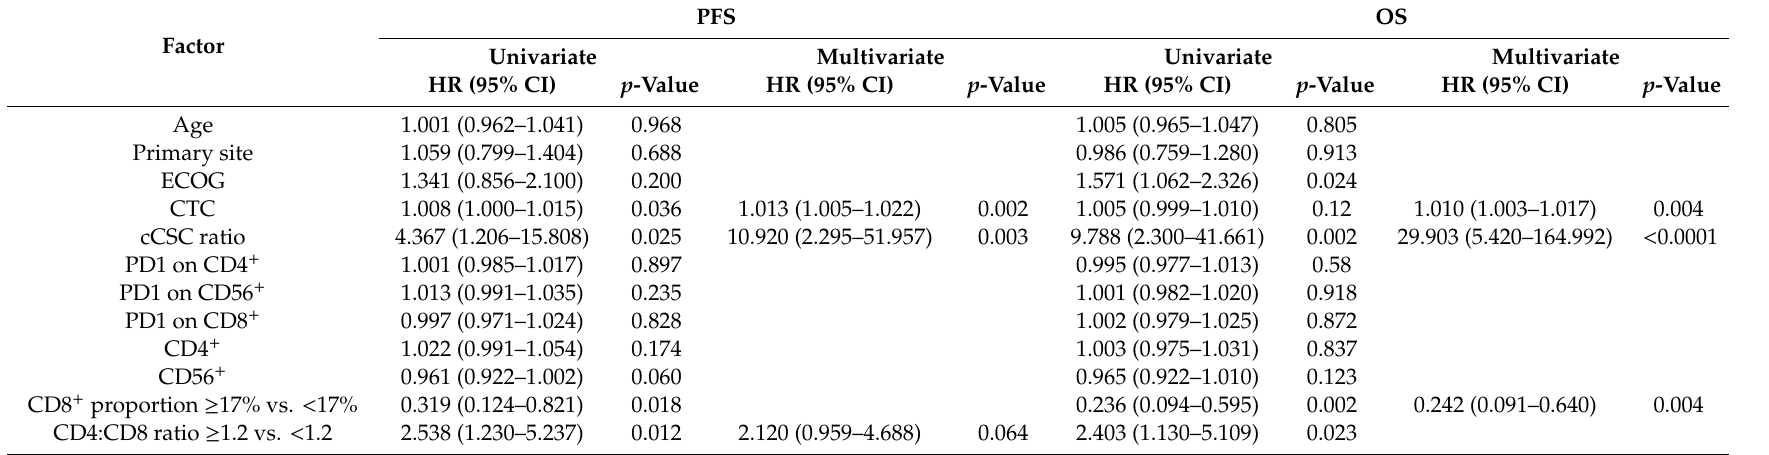
Table 2. Univariate and multivariate analyses of